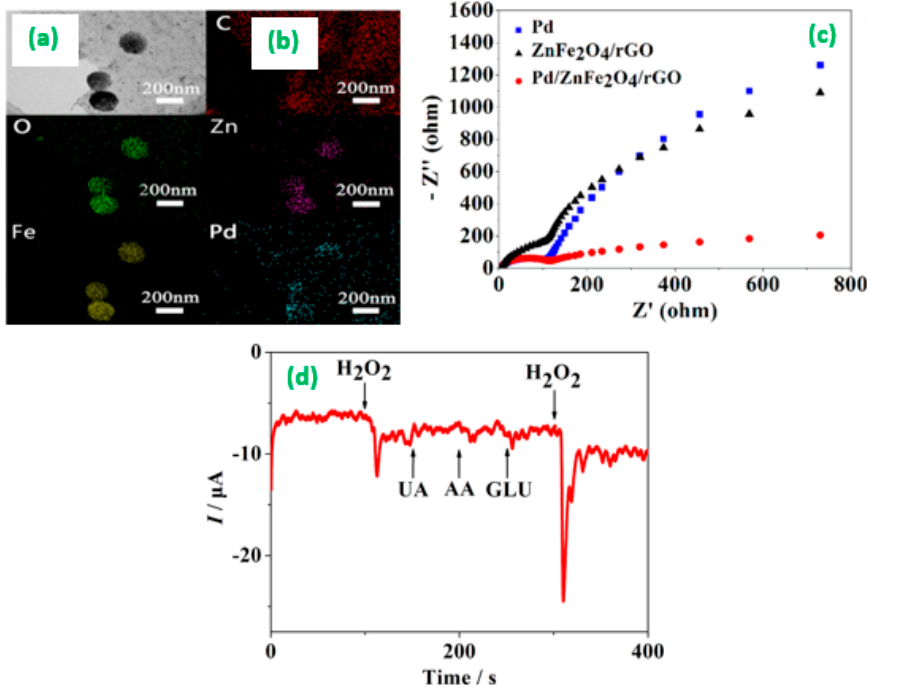
Figure 4. ( a ) TEM image of Pd / ZnFe 2 O 4 / rGO; ( b ) and corresponding elemental mapping images of C, O, Zn, and Fe; ( c ) Nyquist plots of different electrodes in 5.0 mM [Fe(CN) 6 ] 4 − /3 − solution containing 0.2 M KCl and Pd; and ( d ) Amperometric response to successive additions of 0.1 mM H 2 O 2 , 0.1 mM UA, 0.1 mM AA, 0.1 mM GLU, and a second 0.1 mM H 2 O 2 of Pd/ZnFe 2 O 4 /rGO at − 0.2 V in 0.1 M PBS.